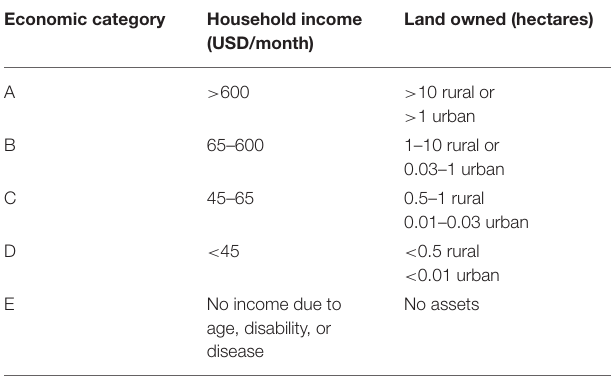
TABLE 2 | Description of economic categories defined by the Rwandan government. Economic